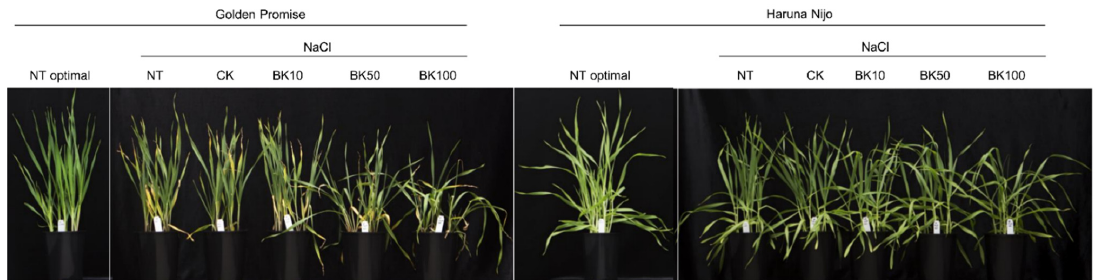
Figure 2. Treatment with bikinin resulted in phenotypic changes in barley growth under normal and salt stress conditions. Barley phenotypes after bikinin treatment with 10 µM, 50 µM, and 100 µM (BK10, BK50, and BK100, respectively) compared to controls with 0.11% DMSO (CK) used as a background for solvent solutions for each bikinin concentration. Non-treated plants (NT) were used as a control for the 0.11% DMSO treatment. Table 2. Results of two-way ANOVA for two barley genotypes (Golden Promise and Haruna Nijo) grown under salt stress (150 mM sodium chloride) after bikinin treatment (non-treated; treated with 0.11% DMSO; and treated with 10 µM, 50 µM, and 100 µM bikinin dissolved in 0.11% DMSO) were calculated for aboveground and belowground organ traits (length; FW, fresh weight; DW, dry weight; area). MS—mean square; F—F-test; p—p -value; red characters—significant changes.